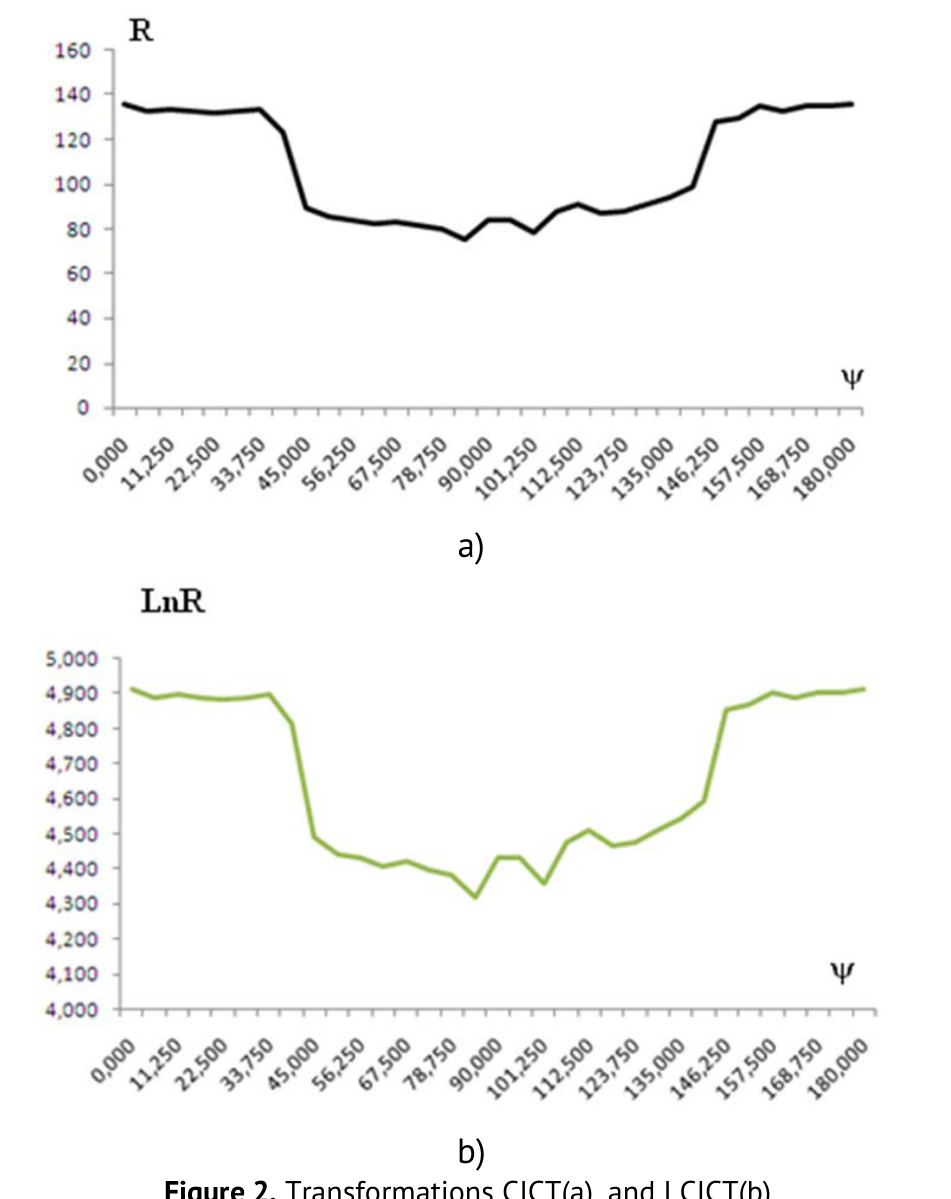
Figure 2. Transformations CICT(a), and LCICT(b).